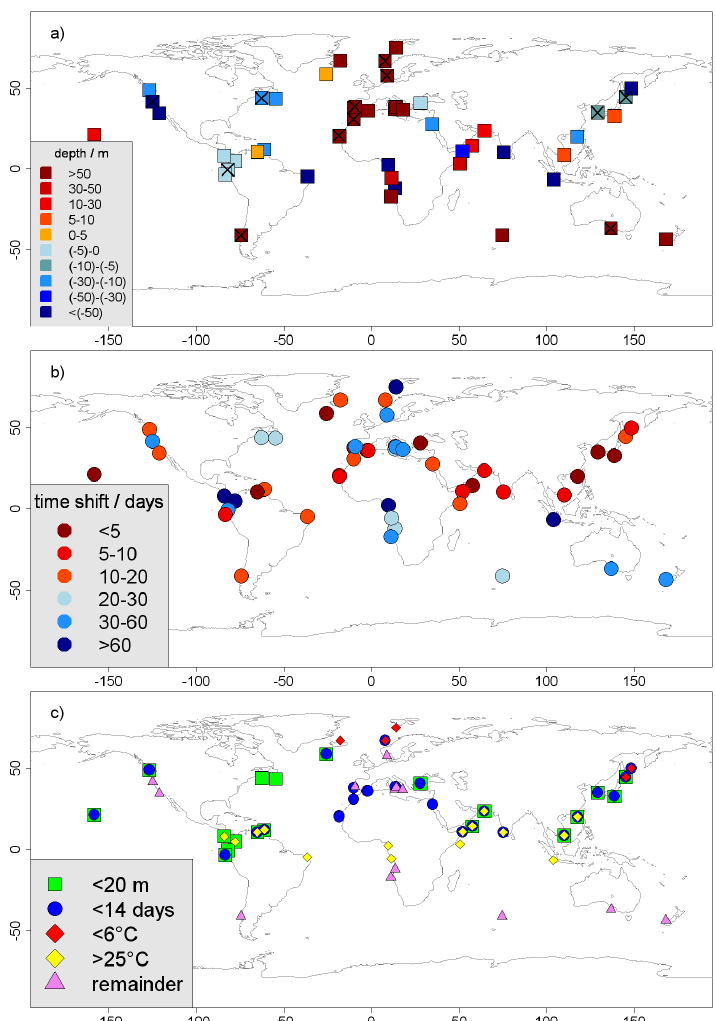
Fig. 12. (a) Vertical shift that is needed to minimize model–data disagreement. (b) Time shift that is needed to minimize model–data disagreement. (c) Global SST trends of the annual mean model output. The icons indicate the location of alkenone proxy records and the time or vertical shift that is needed to minimize the disagreement between the model simulation and data reconstruction. Diamonds are for cores where the calibration maximum causes problems. Triangles are used for reminder cores. Crosses in (a) indicate the record locations where the test of the regression residuals fails to show